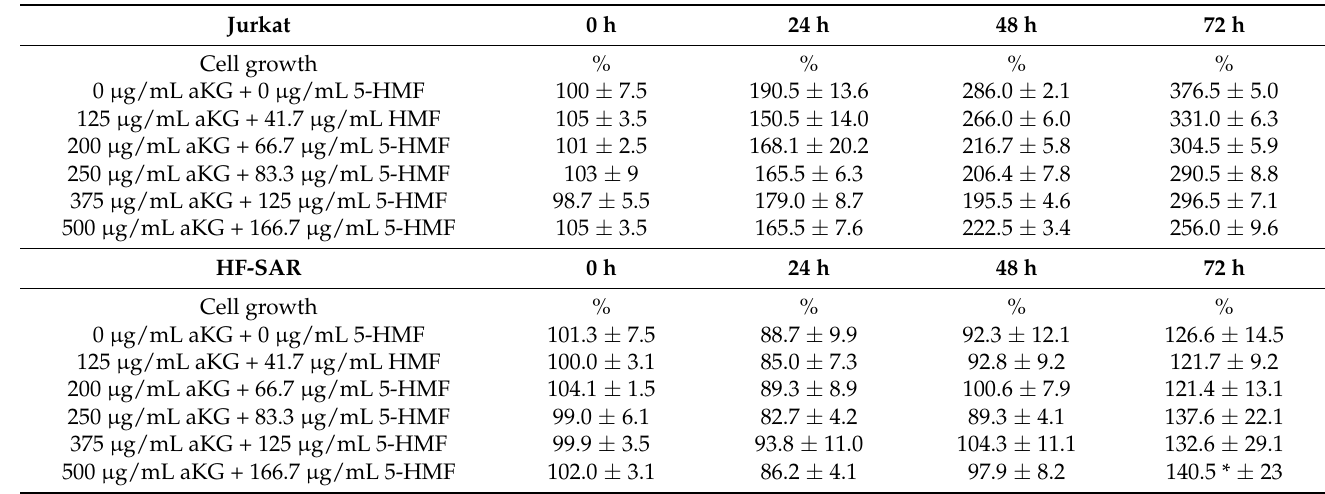
Table 1. Cell proliferation (%) of the Jurkat cell line and of the HF-SAR after incubation for 0, 24, 48, and 72 h in the absence or presence of different combinations of aKG + 5-HMF solutions ( n = 5). Jurkat 0